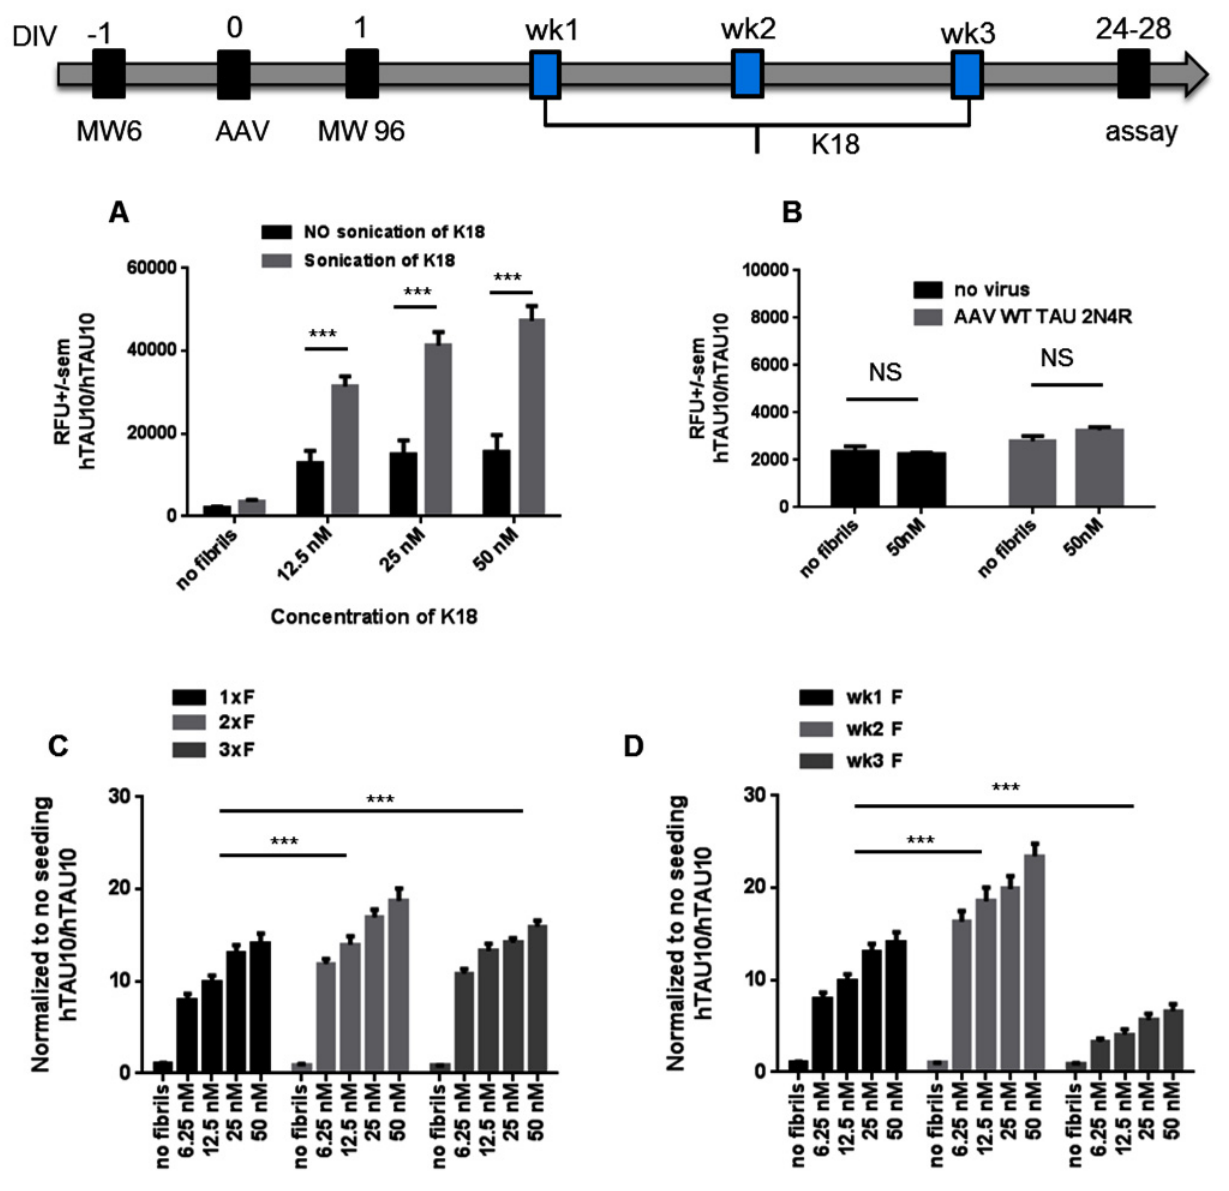
Fig 3. Optimization of dynamic range of hTAU10 aggregation AlphaLISA. (A) K18 sonication significantly improves seeding potency (P < 0.001, n (cid:1) 3 independent experiments). Seeds were added at week 1. In all further experiments, sonicated K18 is used. (B) K18 seeding does not induce aggregation in control (no virus) and WT virus (AAV WT TAU 2N4R) transduced neurons (P = NS; n (cid:1) 3 independent experiments). (C) Weekly repeated K18 seeding of K18 significantly increases the dynamic range (P < 0.001 for both 1xF versus 2xF (wk 1+2) and 1xF versus 3xF (wk1+wk2+wk3); n (cid:1) 3 independent experiments). (D) Finally, also the timing of seeding has an effect on the aggregation potency. Addition of K18 at week 2 (wk2) significantly increases TAU aggregation compared to week 1 (P < 0.001, n (cid:1) 3 independent experiments) while addition of fibrils at week 3 shows significantly less aggregation (P < 0.001; n (cid:1) 3 independent experiments) probably due to the shorter (1 week) K18 incubation period before AlphaLISA. *** P < 0,001; 2-way-ANOVA with Dunnett ’ s post